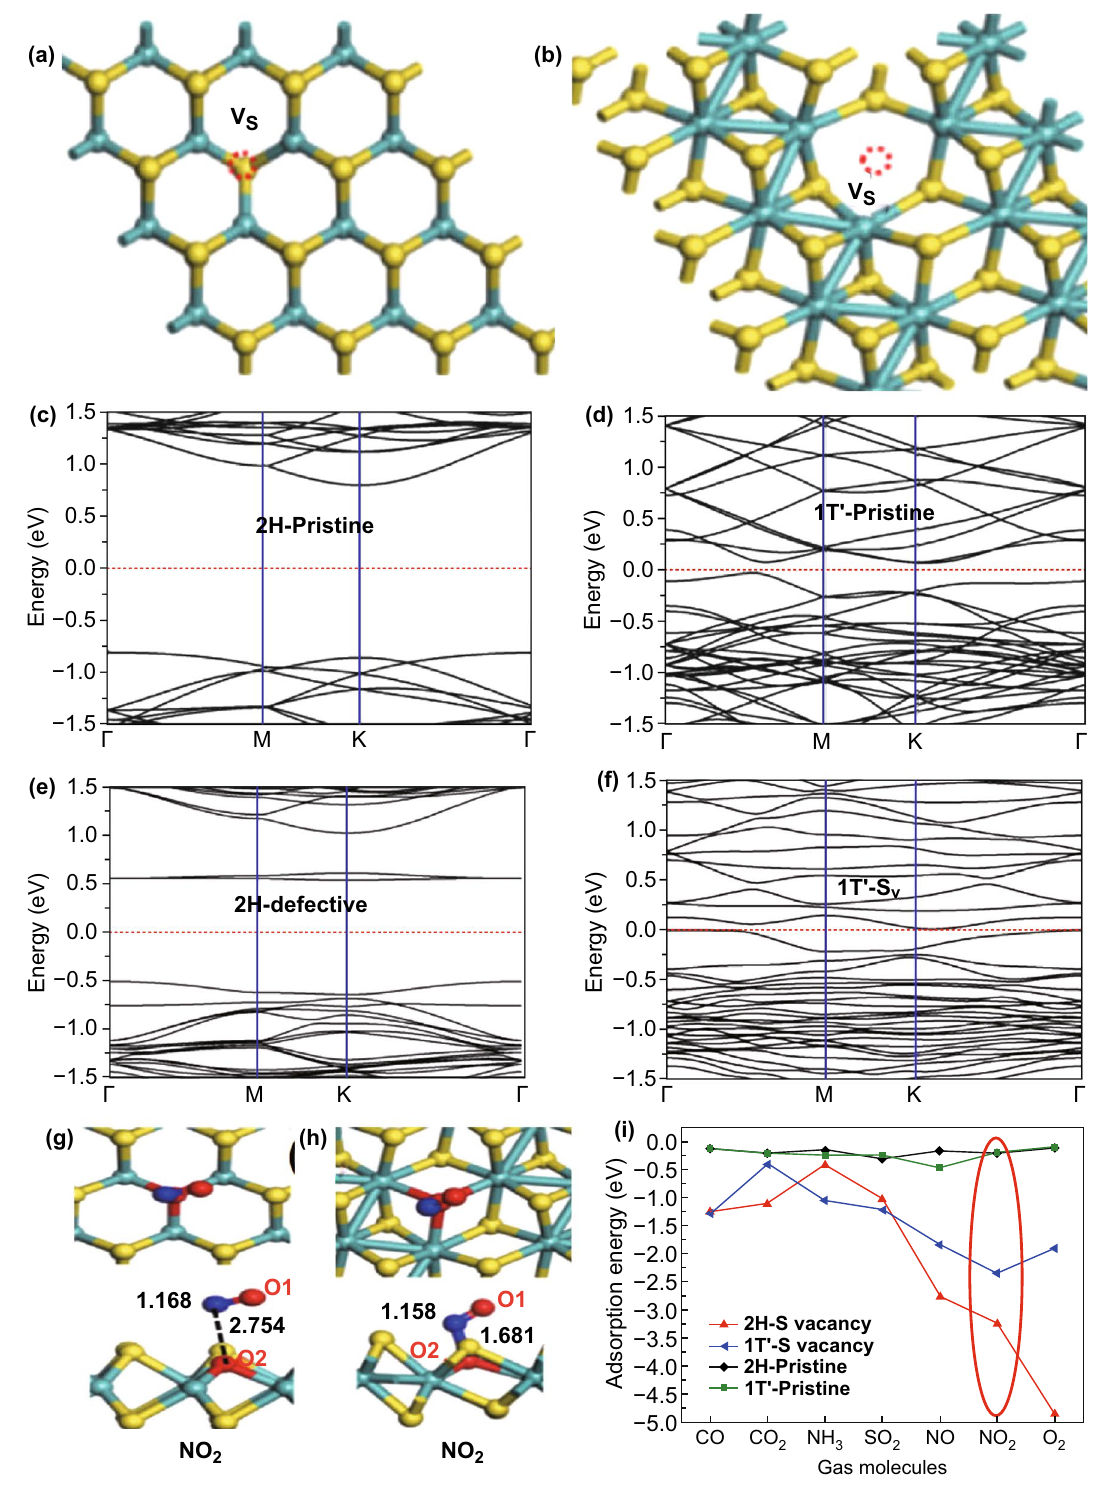
Fig. 7 a S vacancy in 2H-MoS 2 . b S vacancy in 1T-MoS 2 . Band structure of c pristine 2H-MoS 2 , d pristine 1T-MoS 2 , e S vacant 2H-MoS 2 , f S vacant 1T-MoS 2 . Adsorption of NO 2 on g defective 2H-MoS 2 , h defective 1T-MoS 2 . i Variation of adsorption energy for different molecules. Reproduced from Ref. [286]. Copyright (2019) American Chemical